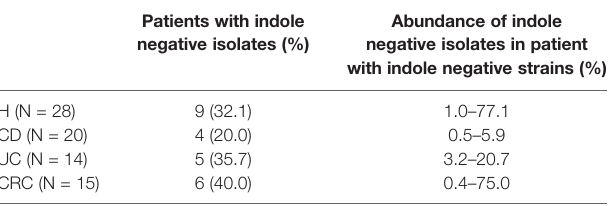
TABLE 2 | Prevalence and abundance of indole-negative isolates obtained from each group of